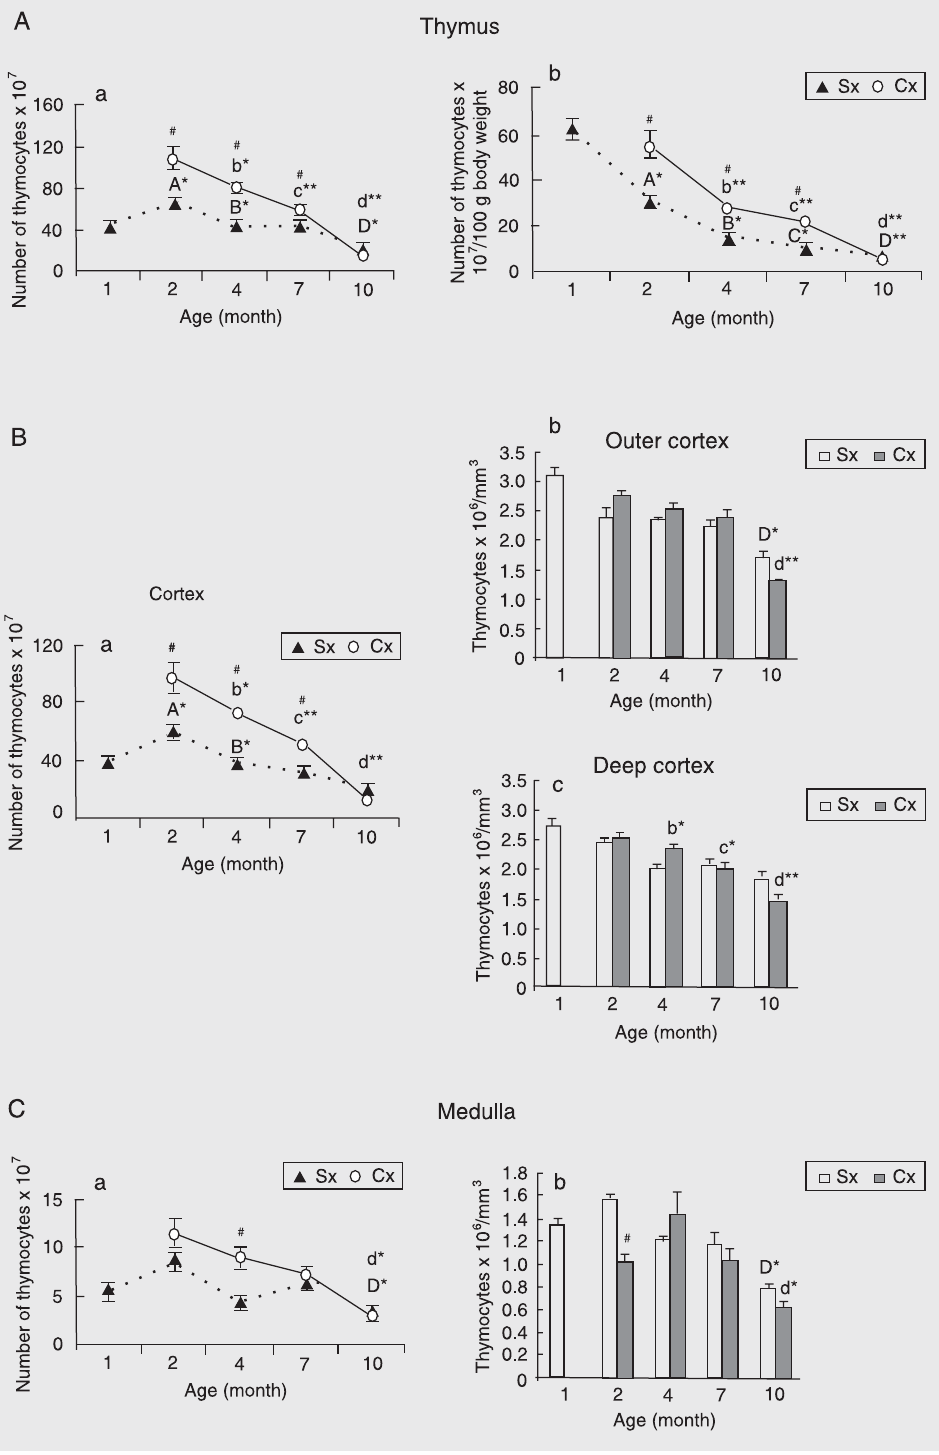
Figure 3. A , Age-related changes in the (a) total and (b) relative number of thymocytes, as well as in the number of thymocytes (B, a and C, a) and in thymocyte numerical density in the (B, b,c) thymic cortex and (C, b) medulla in rats orchidectomized at the age of 30 days (Cx) and control animals (Sx). Data are reported as means ± SEM for N = 5. A 2- month-old Sx vs 30-day-old Sx; B 4-month-old Sx vs 2-month-old Sx; C 7-month-old Sx vs 4- month-old Sx; D 10-month-old Sx vs 7-month-old Sx; # Cx vs age- matched controls; b 4-month-old Cx vs 2-month-old Cx; c 7-month- old Cx vs 4-month-old Cx; d 10- month-old Cx vs 7-month-old Cx. *P < 0.05 and **P < 0.01; #